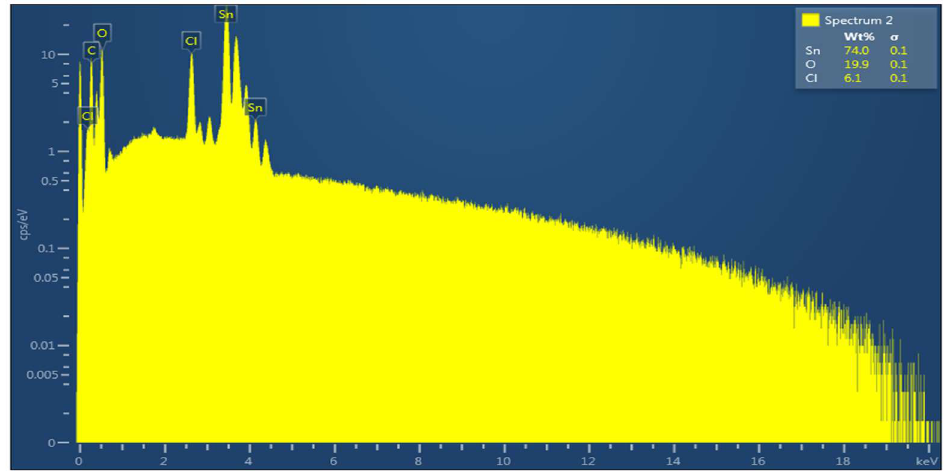
Figure 5. EDX spectrum of SnO 2 nanoparticles .